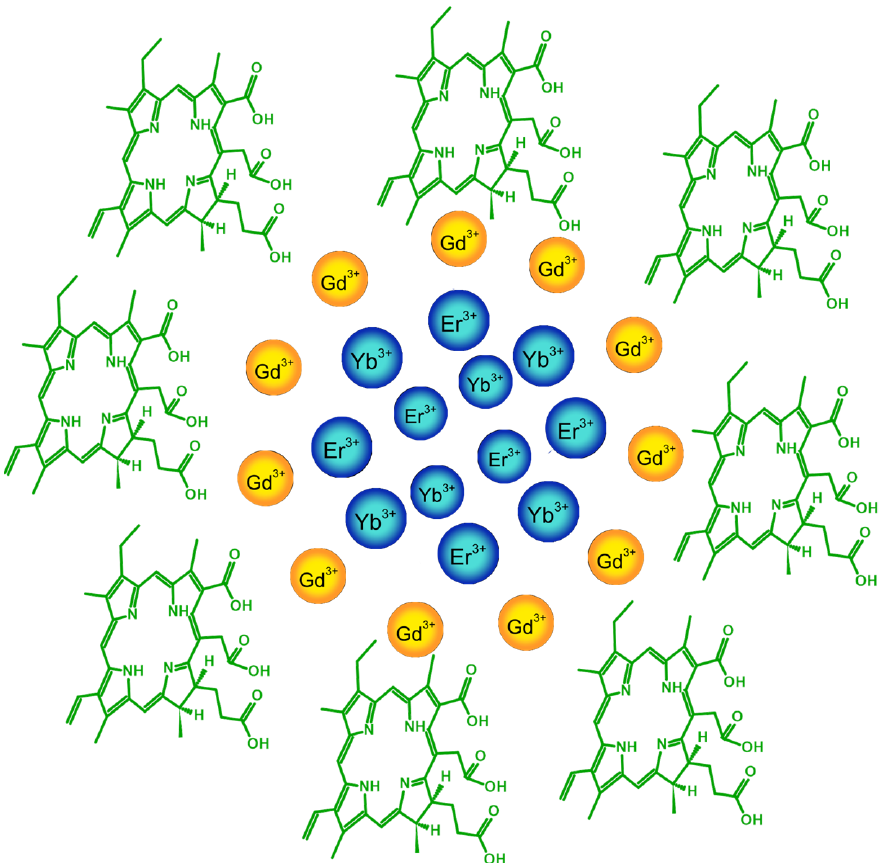
Figure 7. Chemical structure of upconverted nanoparticle/Ce6 conjugates, which were obtained by Park et al. [48].